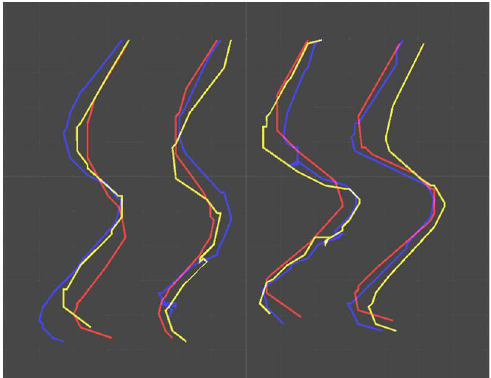
Fig. 22 No warning vs warning; order of experiment: r,o,s